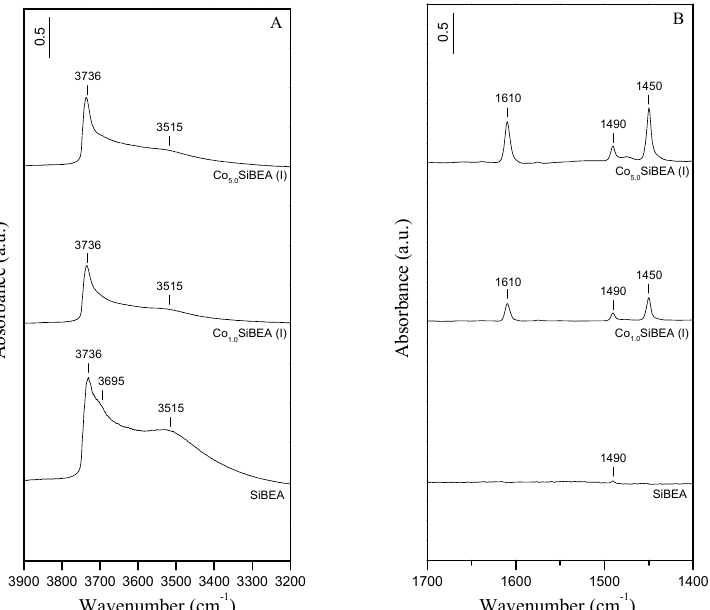
Figure 3. ( A ) FTIR spectra (vibration region of the OH groups) recorded at room temperature of SiBEA, Co 1.0 SiBEA(I), and Co 5.0 SiBEA(I) and ( B ) FTIR difference spectra recorded at room temperature of SiBEA, Co 1.0 SiBEA(I), and Co 5.0 SiBEA(I) after adsorption of pyridine (133 Pa) for 1 h at room temperature and desorption at 150 ◦ C for 1 h.